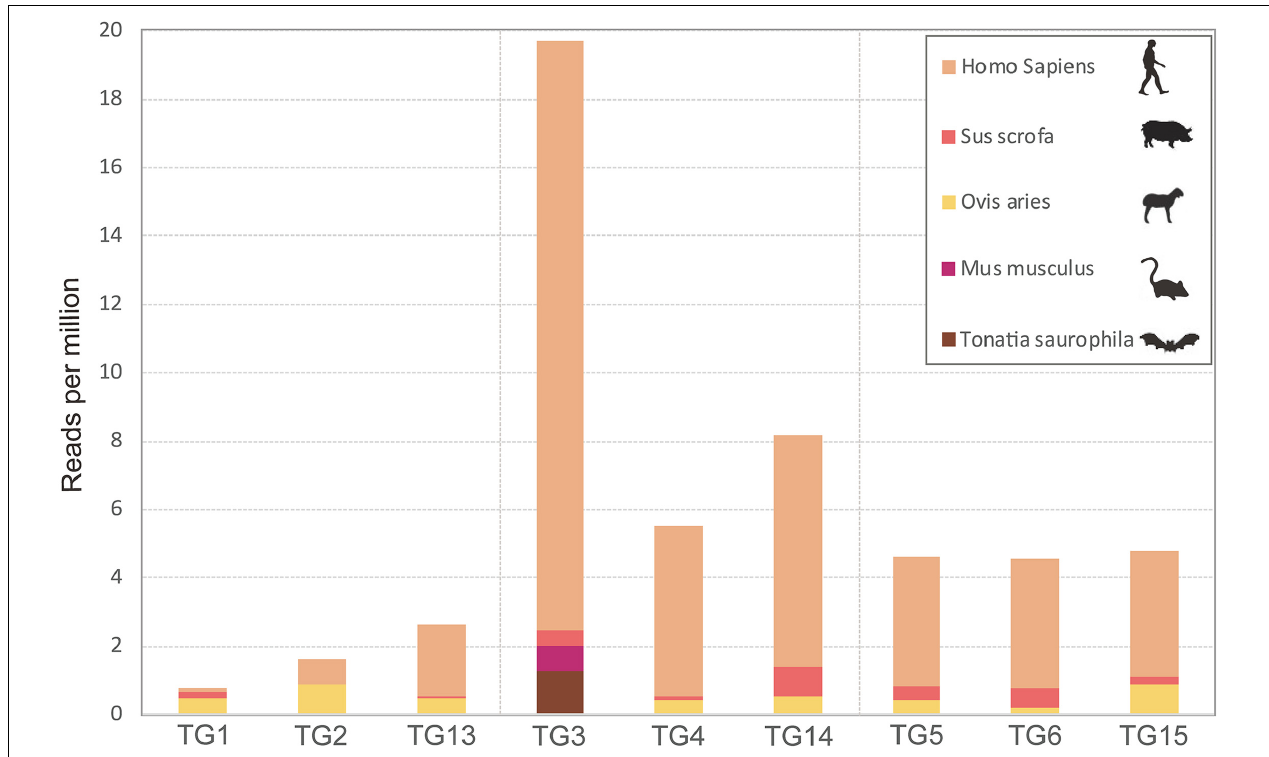
FIGURE 1 | Expression levels of the cytochrome c oxidase subunit I gene of various host species revealed by RNAseq analysis of pools of Ixodes persulcatus ticks removed from human patients at Mudanjiang Forestry Central Hospital in Heilongjiang Province, China. Ticks were divided into three groups each comprising three pools of ten ticks: flat (pools TG1, TG2, and TG13), partially fed (pools TG3, TG4, and TG14), and fully fed (pools TG5, TG6, and TG15).